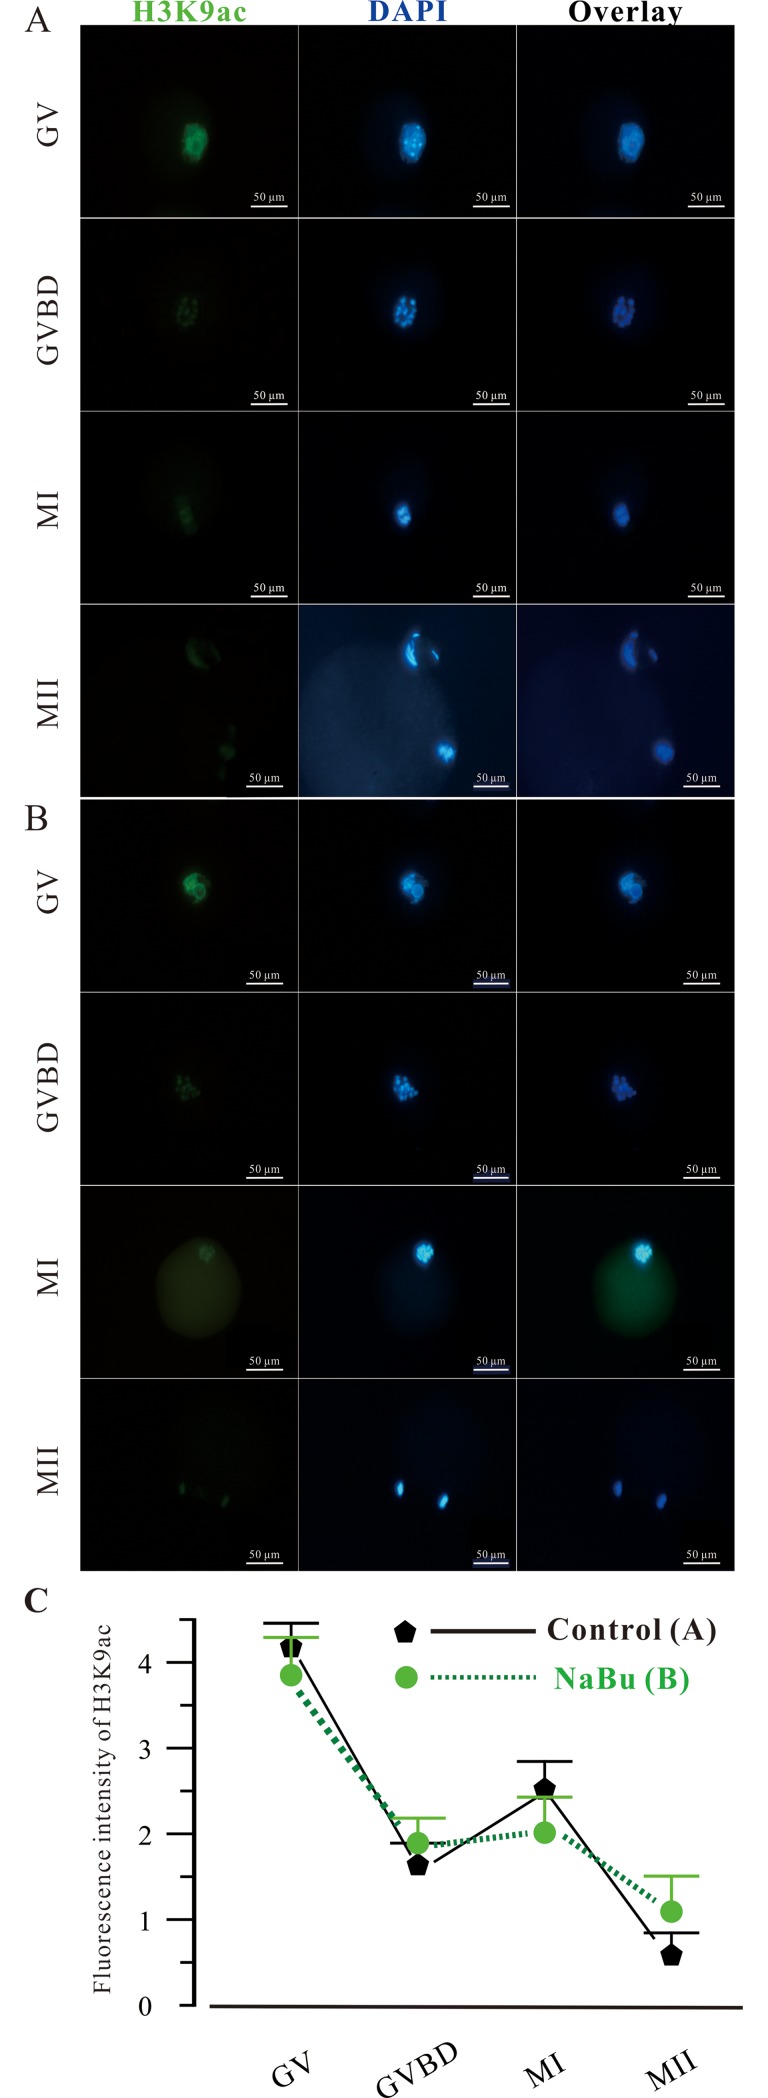
Effects of NaBu on dynamic changes in H3K9ac during the maturation of mouse oocytes.Mouse GV stage oocytes were obtained and cultured in KSOM without/with 2 mM NaBu in vitro. The cultured oocytes were collected at the GVBD, MI, and MII stages to analyze the expression level of H3K9ac using immunofluorescence techniques. The oocytes at different stages were immunostained using anti-H3K9ac antibody (green). The DNA was counterstained using DAPI (blue). Scale bar: 50 μM. (A) Control group, (B) NaBu group, and (C) summary of H3K9ac expression in (A) and (B).